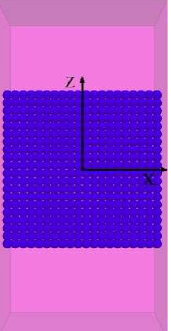
Figure 16. Arrangement of measurement circles in samples.